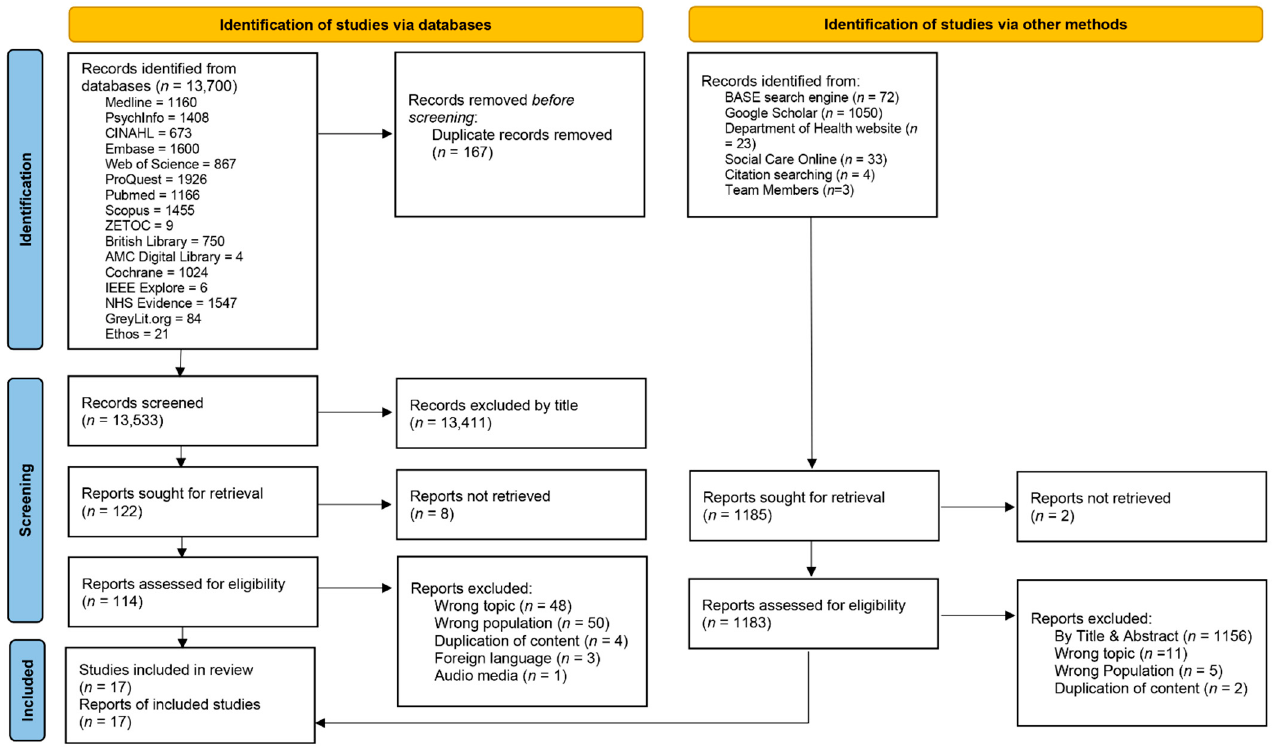
Figure 1. PRISMA flow diagram of the selection process. Adapted from the preferred reporting items for systematic review and meta-analyses (PRISMA) flow diagram [44].